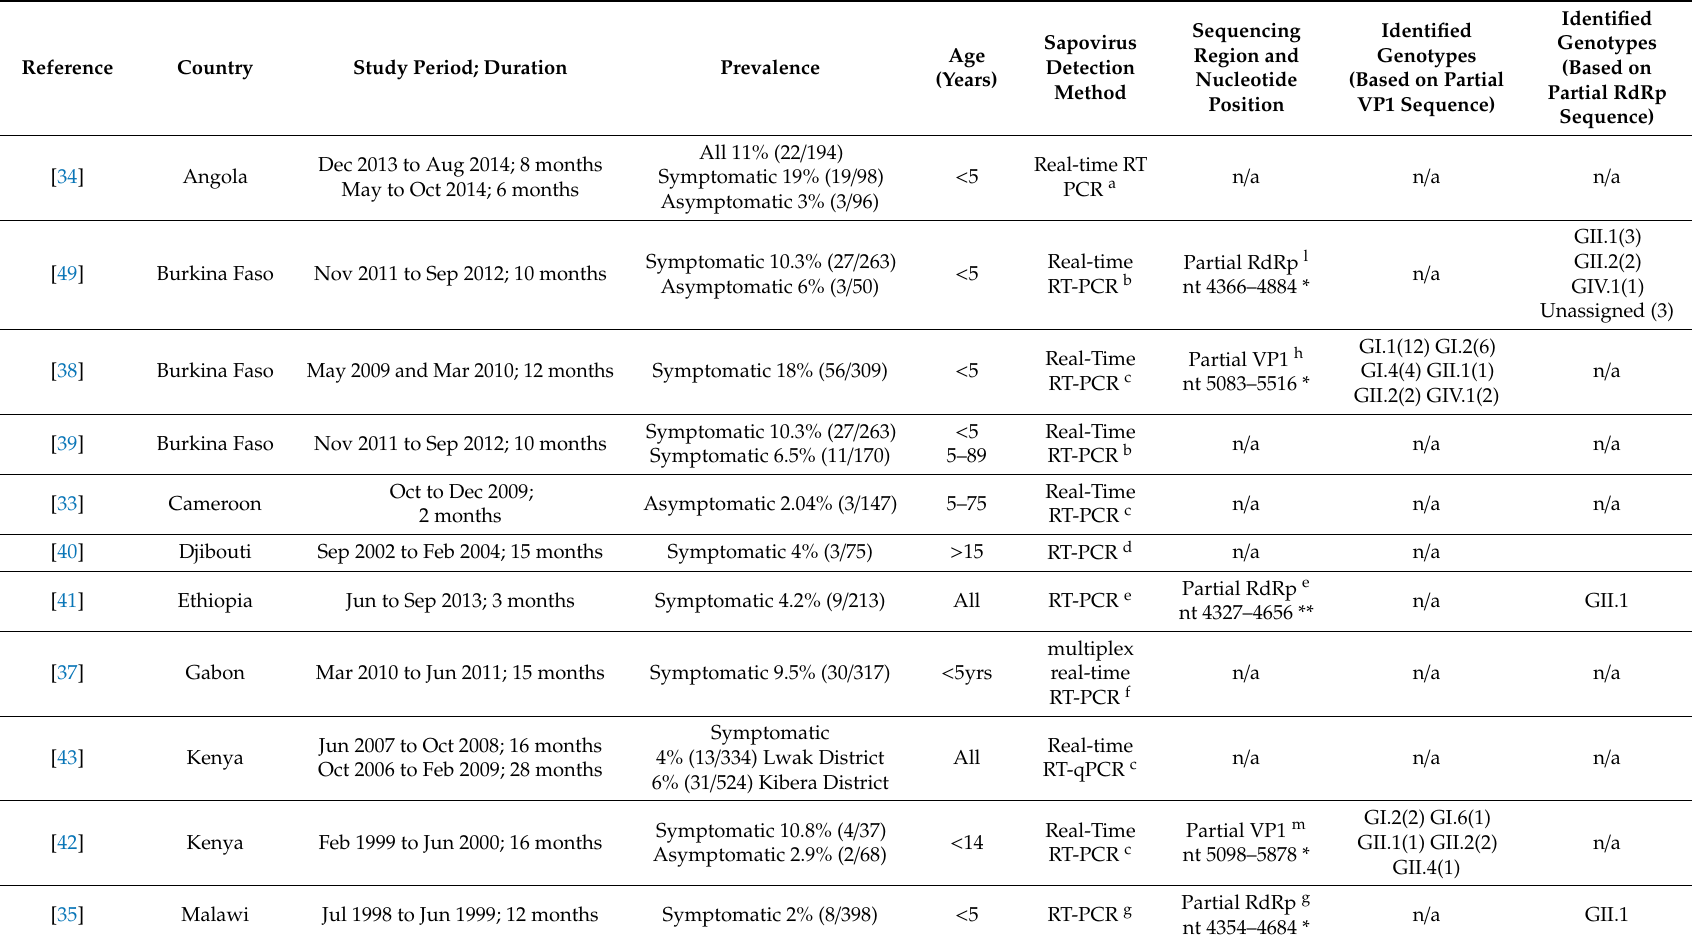
Table 2. Summary of reported studies on human sapovirus infections in